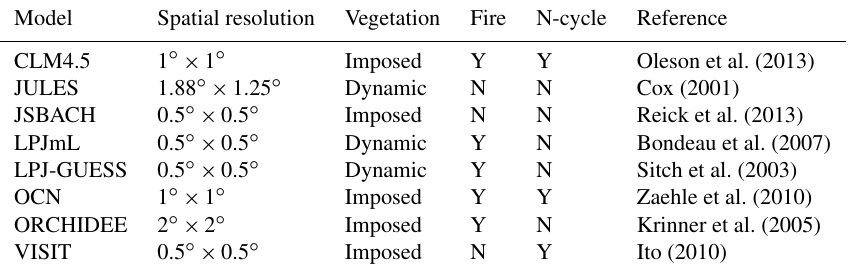
Table 1. Summary of the dynamics global vegetation models used to estimate L DGVM . More details about the way each model represents LUC may be found in Le Quéré et al.